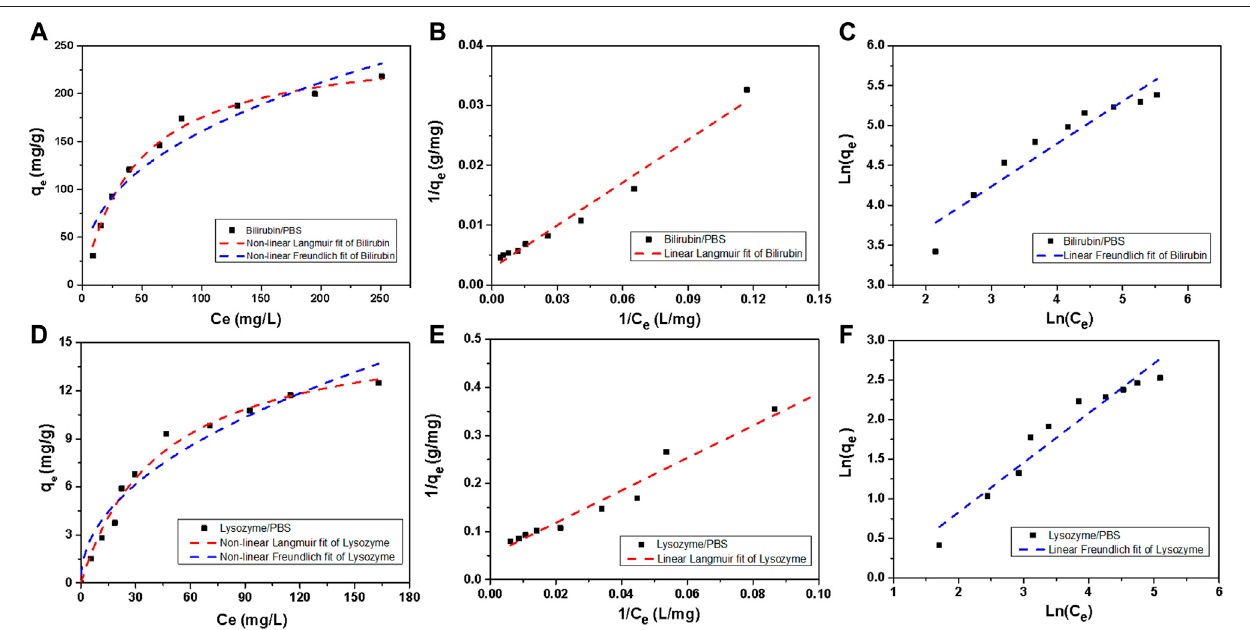
FIGURE 7 | Bilirubin and lysozyme adsorption isotherms of HCP(St-DVB-VP). (A,D) Non-linear Langmuir and non-linear Freundlich, (B,E) linear Langmuir, and (C,F) linear Freundlich model fi tting plots.